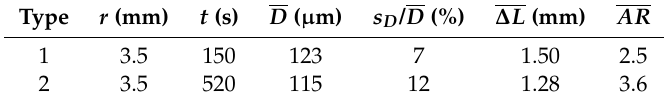
Table 3. Mean geometrical parameters for sets of nozzles fabricated from capillaries of different thicknesses ( z = 15 mm).